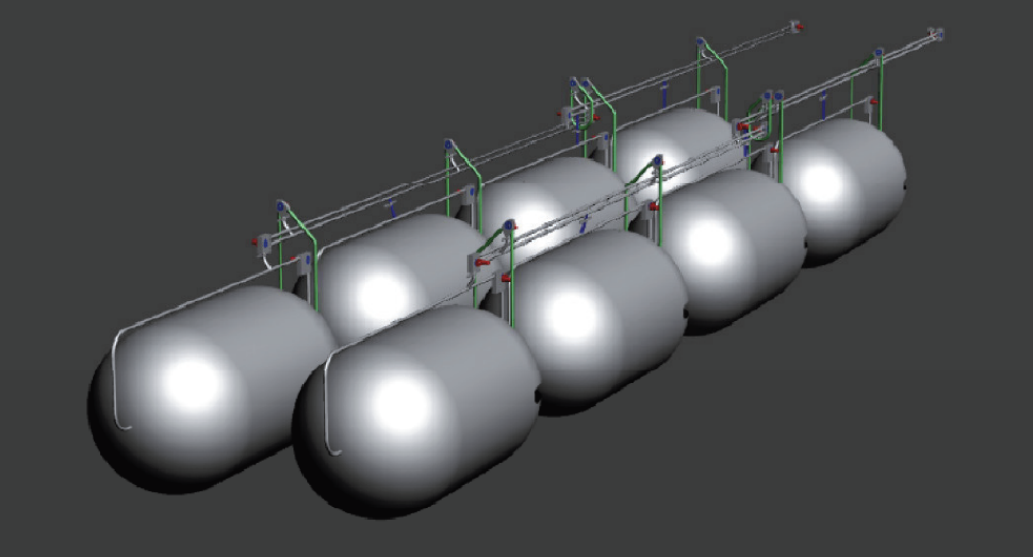
Figure 6. Conceptual design of horizontally pivoted cylindrical